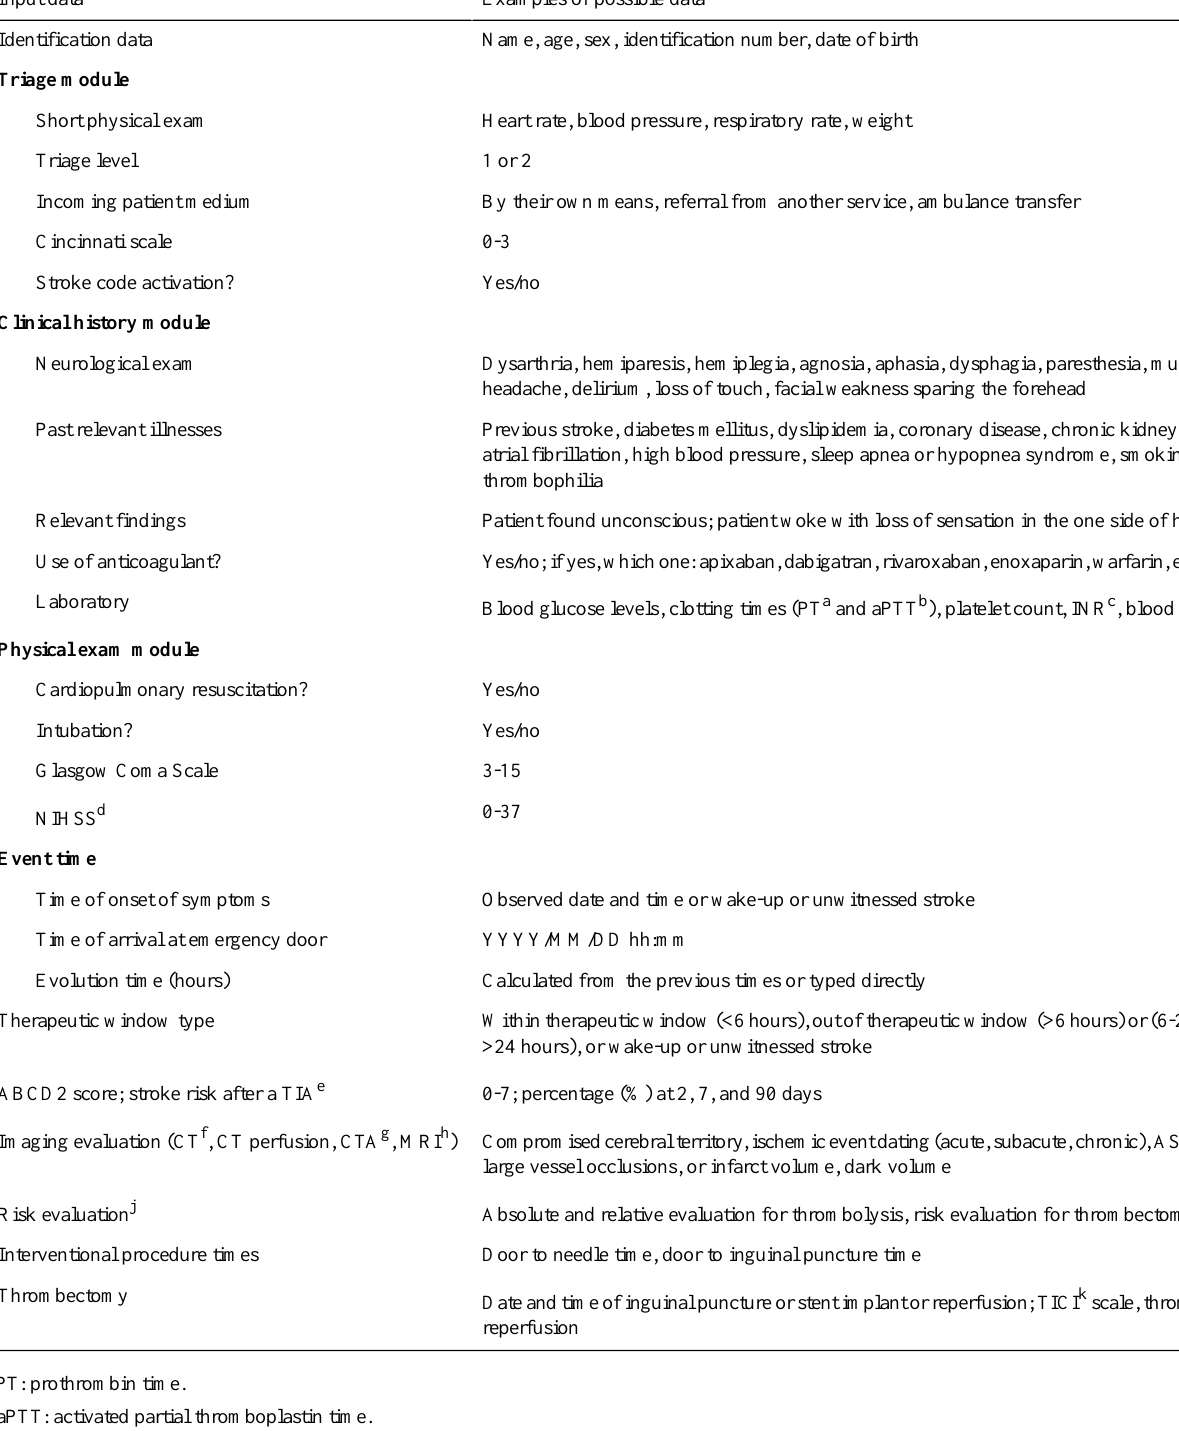
Examples of possible dataInput